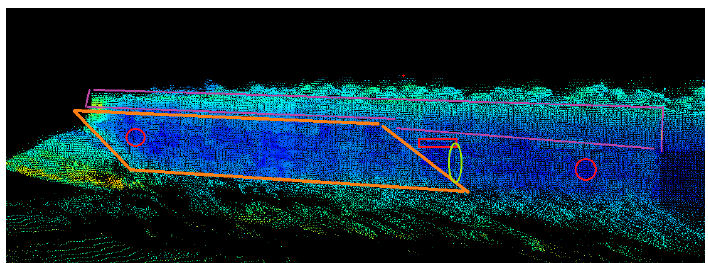
Figure 9. Thermographic image of the walls, registered on the Terrestrial Light Detection and Ranging (T-LiDAR) data for the visualization of complete walls within one product. The following pathologies are highlighted: stones losing material (red circle), lack of union material (red square) and presence of vegetation (green circle). Stones from before and after restoration activities are also marked (orange and purple curves, respectively).